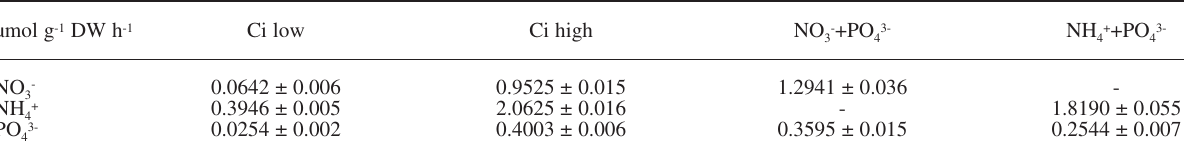
Table 3.- Net nutrient uptake rates by C. linum, after the first 74 hours of incubation in control jars (Ci low), in those enriched with NO 3- or NH 4+ or PO 43- (Ci high), and in those enriched with NO 3- + PO 43- and NH 4+ + PO 43- . Values are means ± standard errors. µmol g -1 DW h